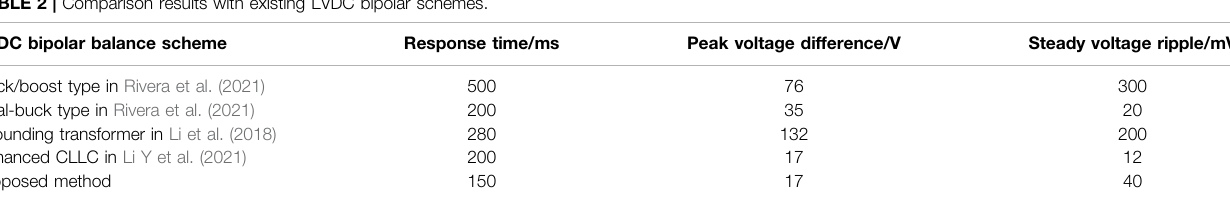
TABLE 2 | Comparison results with existing LVDC bipolar